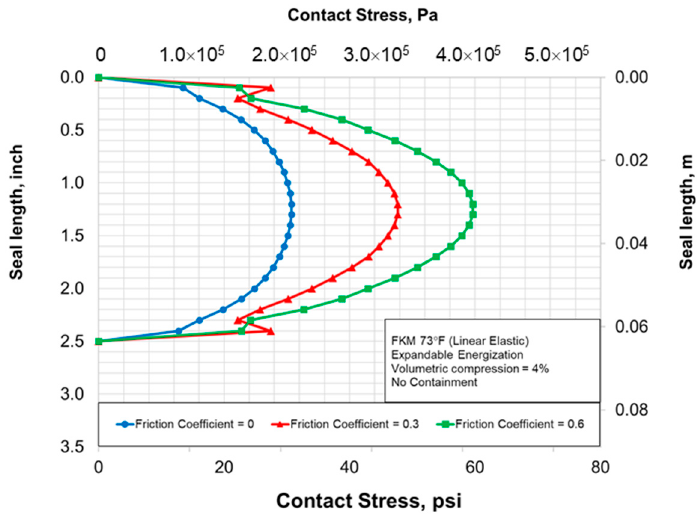
Figure 17. Effect of friction on contact stress profile in expandable seal assembly.